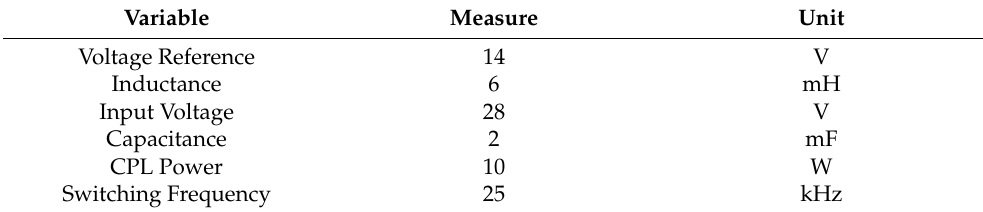
Table 2. Buck converter parameters